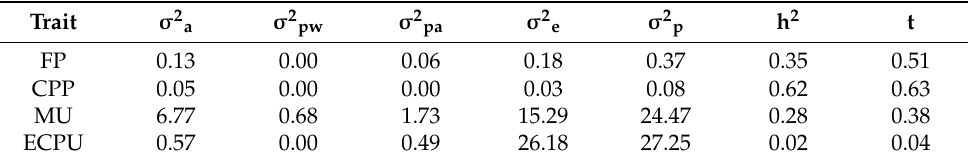
Table 3. Estimates of variance components, heritabilities and repeatabilities of milk percentage traits, milk urea and efficiency of crude protein utilization using a univariate repeatability animal model in grazing dairy cows at Massey University Dairy 1 and Dairy 4. Trait σ 2 a σ 2 pw σ 2 pa σ 2 e σ 2 p h 2 FP 0.13 0.00 CPP 0.05 MU ECPU FP = fat percentage, CPP = crude protein percentage, MU = milk urea concentration, ECPU = efficiency of crude protein utilization, σ 2 a = additive genetic variance, σ 2 pw = within lactation permanent environment variance, σ 2 pa = across lactation permanent environment variance, σ 2 e = residual variance, σ 2 p = phenotypic variance ( σ 2 a + σ 2 pw + σ 2 pa + σ 2 e ), h 2 = trait heritability ( σ 2 a / σ 2 p ), t = repeatability ([ σ 2 a + σ 2 pw + σ 2 pa ]/ σ 2 p